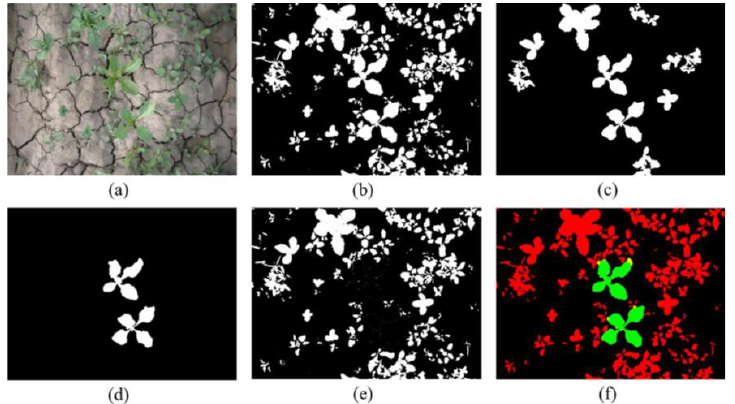
Figure 13. Results from steps of the SBWD algorithm: ( a ) initial RGB image; ( b ) segmented plants using EXG method; ( c ) the result after morphological filtering of small objects; ( d ) segmented sugar beets with SBWD algorithm; ( e ) subtraction of image ( c ) from image ( b ) showing the weeds; ( f ) result of SBWD algorithm showing weeds, sugar beet and false negatives [41].